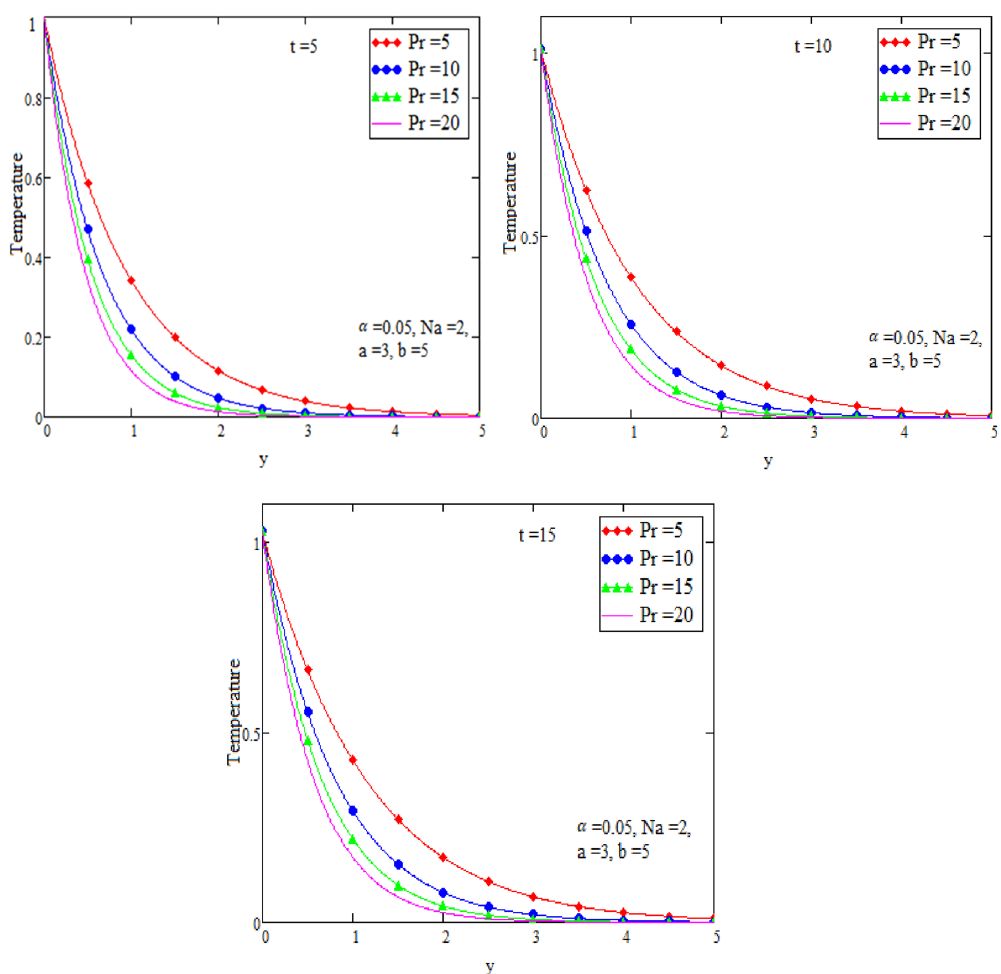
Figure 3. Graph of temperature for different value of Prandtl number